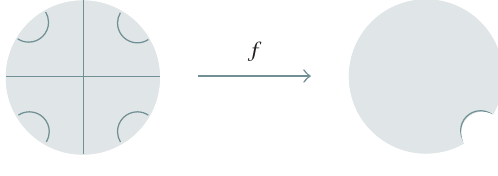
Figure 2.1. Singular set of a hyperbolic